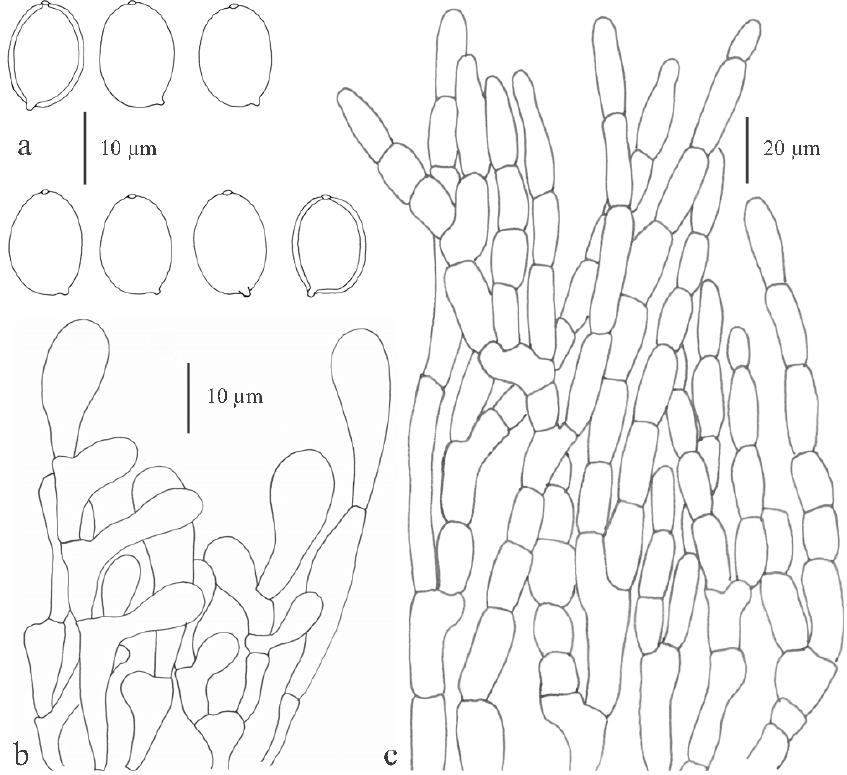
Figure 16. Microcharacters of Macrolepiota detersa (MFLU 192-351). ( a ) basidiospores. ( b ) cheilocystidia. ( c ) pileus cover- ing. Pileus 60–160 mm, when young globose to subglobose, expanding to convex, umbo- nate, broadly campanulate, plane-umbonate, with straight or decurrent margin; when young glabrous, brownish-orange to light-brown or dark red-brown (7C5–6, 8–9 F7–8), surface-breaking around the center, with concolorous squamules or patches around gla- brous calotte at the center toward the margin, crowded, with distantly fragile patches to- ward margin), with concolorous brownish-orange (7C5–6) fibrillose squamules or squamules between patches towards the margin, on white to yellowish-white (4A2) mat- ted-fibrillose to the felted background; margin splitted, covered with light-grey (6C3) to grey orange (6B3) granular-floccose Universal Veil elements. Lamellae free, slightly re- mote from the stipe, white, sometimes with reddish spots, ventricose to broad, 8–16 mm wide, close to crowded, with the eroded edge. Stipe 80–400 × 12–18 mm, cylindrical with slight wider downward base, with bulb at base, 20–30 mm; dull, dry, scurfy to squamulose overall, minute squamules at apex zone to middle and squamules downward base, con- colorous with those squamules on pileus, on brown-grey (6C3) background. Annulus su- perior, membranous, thin, descending, double, persistent but easily removable, pendu- lous, 30–40 mm long, with concolorous squamules underside of internal cuff-liked. Con- text white and thick in pileus; stipe white and hollow, fibrous, turning pinkish-grey when cut, not changing color in bulb. Taste not observed. Smell strong, pleasant. Spore print white. Basidiospores [50,2,2] 14–16.2 × 9.5–11 µm, avl × avw = 15.2 × 10.1 µm, Q = 1.45–1.62, avQ = 1.52, ellipsoid amygdaliform, ellipsoid to oblong in frontal view, with apical germ pore and hyaline cap, hyaline and thick-walled, dextrinoid, congophilous, cyanophilous,